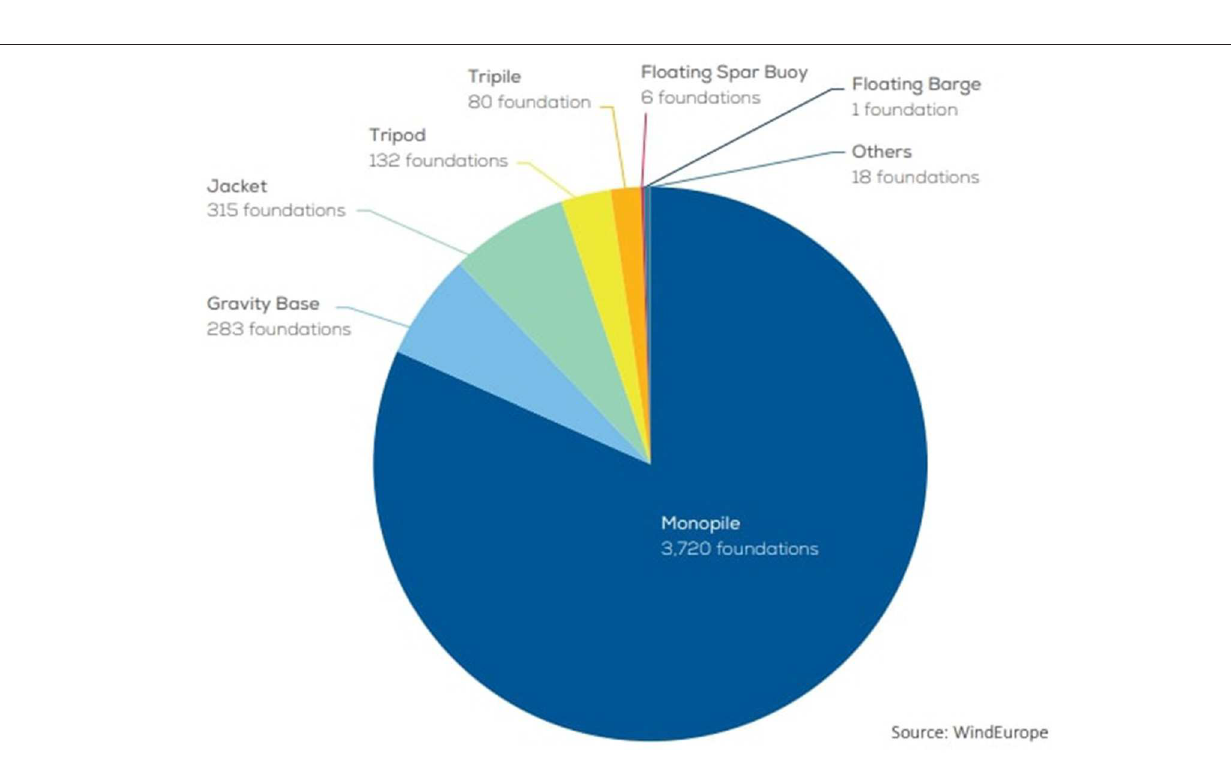
FIGURE 3 | Number of foundations according to its type. Reproduced from